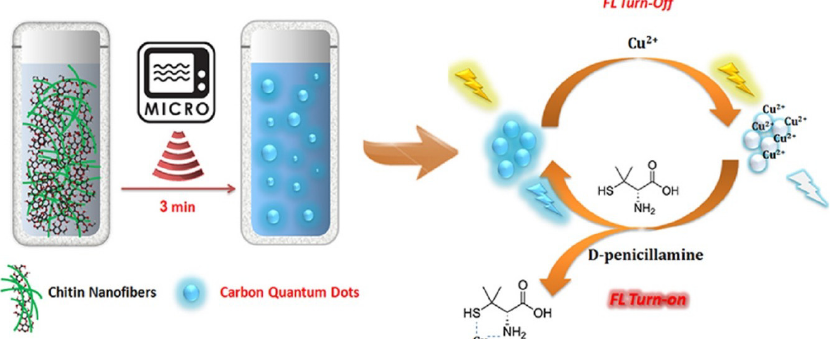
Figure 3. Schematic of the process of microwave-assisted synthesis of CQDs and “on-off” transformation of CQDs-Cu 2+ . Reproduced with permission from [63]. Copyright Journal of Industrial and Engineering Chemistry, 2017.